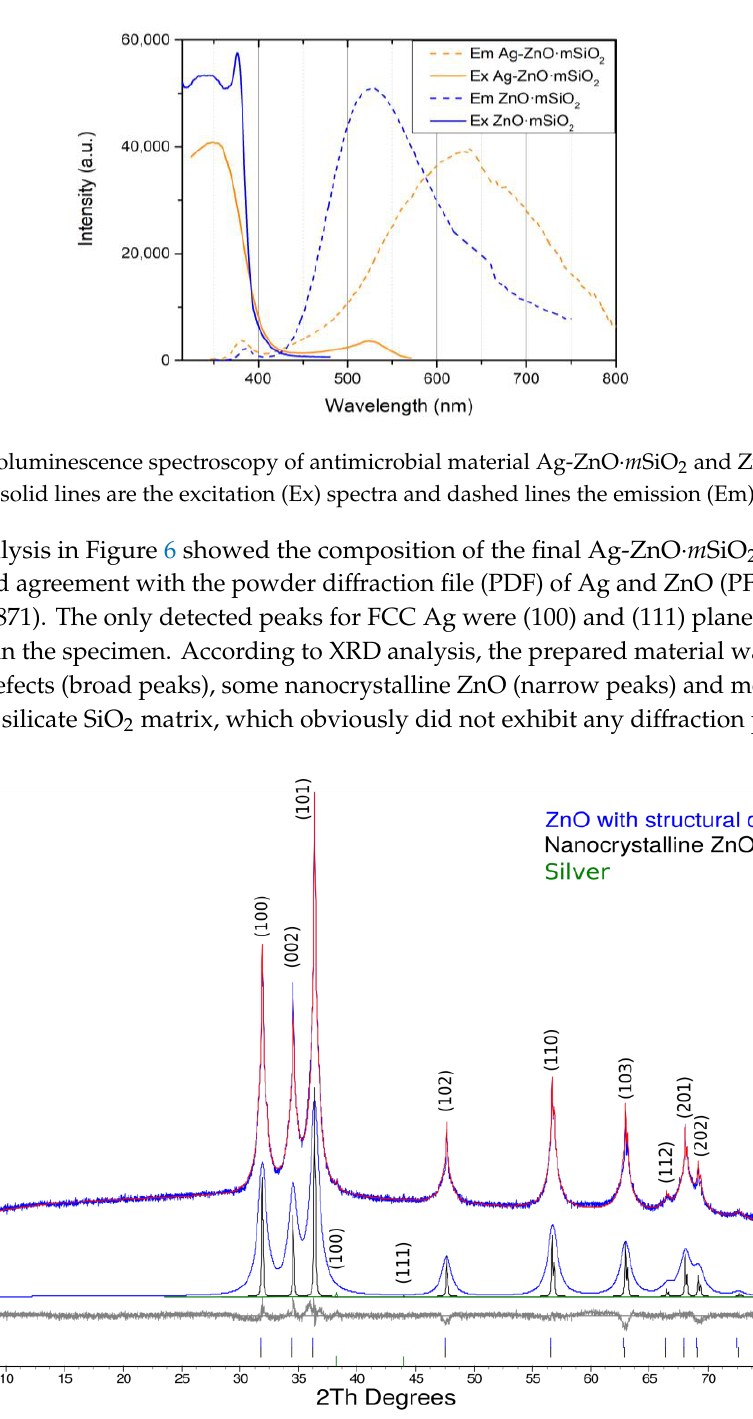
Figure 6. XRD pattern of antimicrobial material Ag-ZnO· m SiO 2 . The main top pattern is decomposed to ZnO with structural defects (blue), nanocrystalline ZnO (black) and Ag (green).